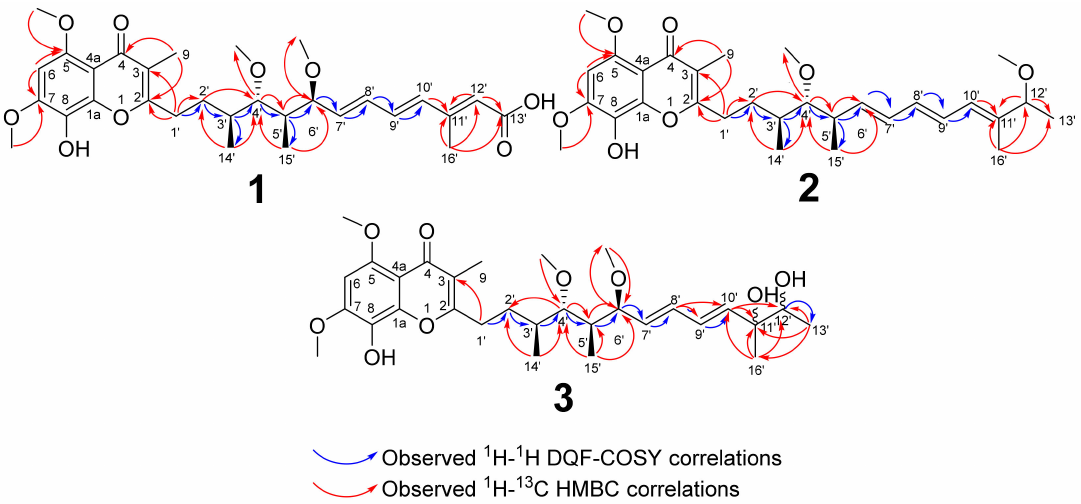
Figure 3. Key 1 H- 1 H COSY and 1 H- 13 C HMBC correlations for 1 , 2 and 3 . Compound 2 with a molecular formula of C 30 H 42 O 7 observed from HRMS molecular observed MS 2 fragments 335.1501 (C 18 H 23 O 6+ ), 303.1238 (C 17 H 19 O 5+ ), 263.0924 (C 14 H 15 O 5+